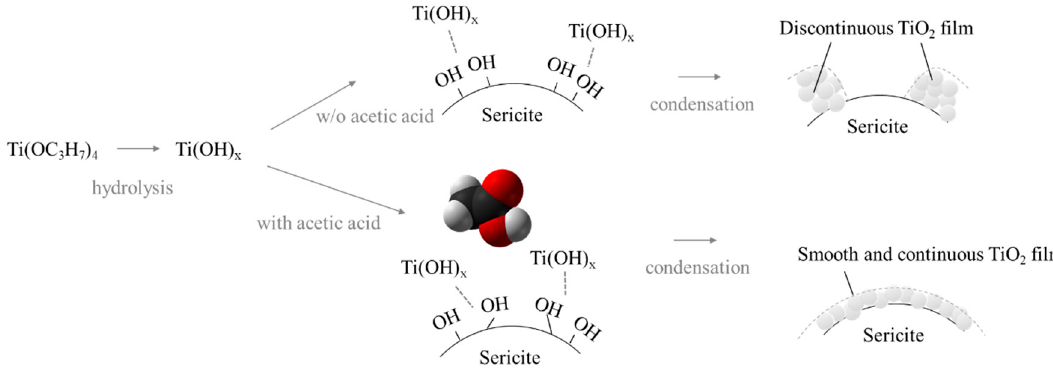
/ sericite formation with and without acetic acid.